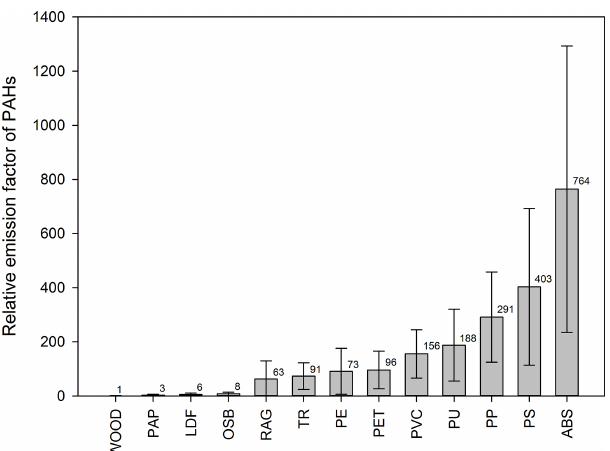
Figure 4. Emission factors of total PAHs for different waste types relative to the burning of dry fuel wood with a fixed experimental